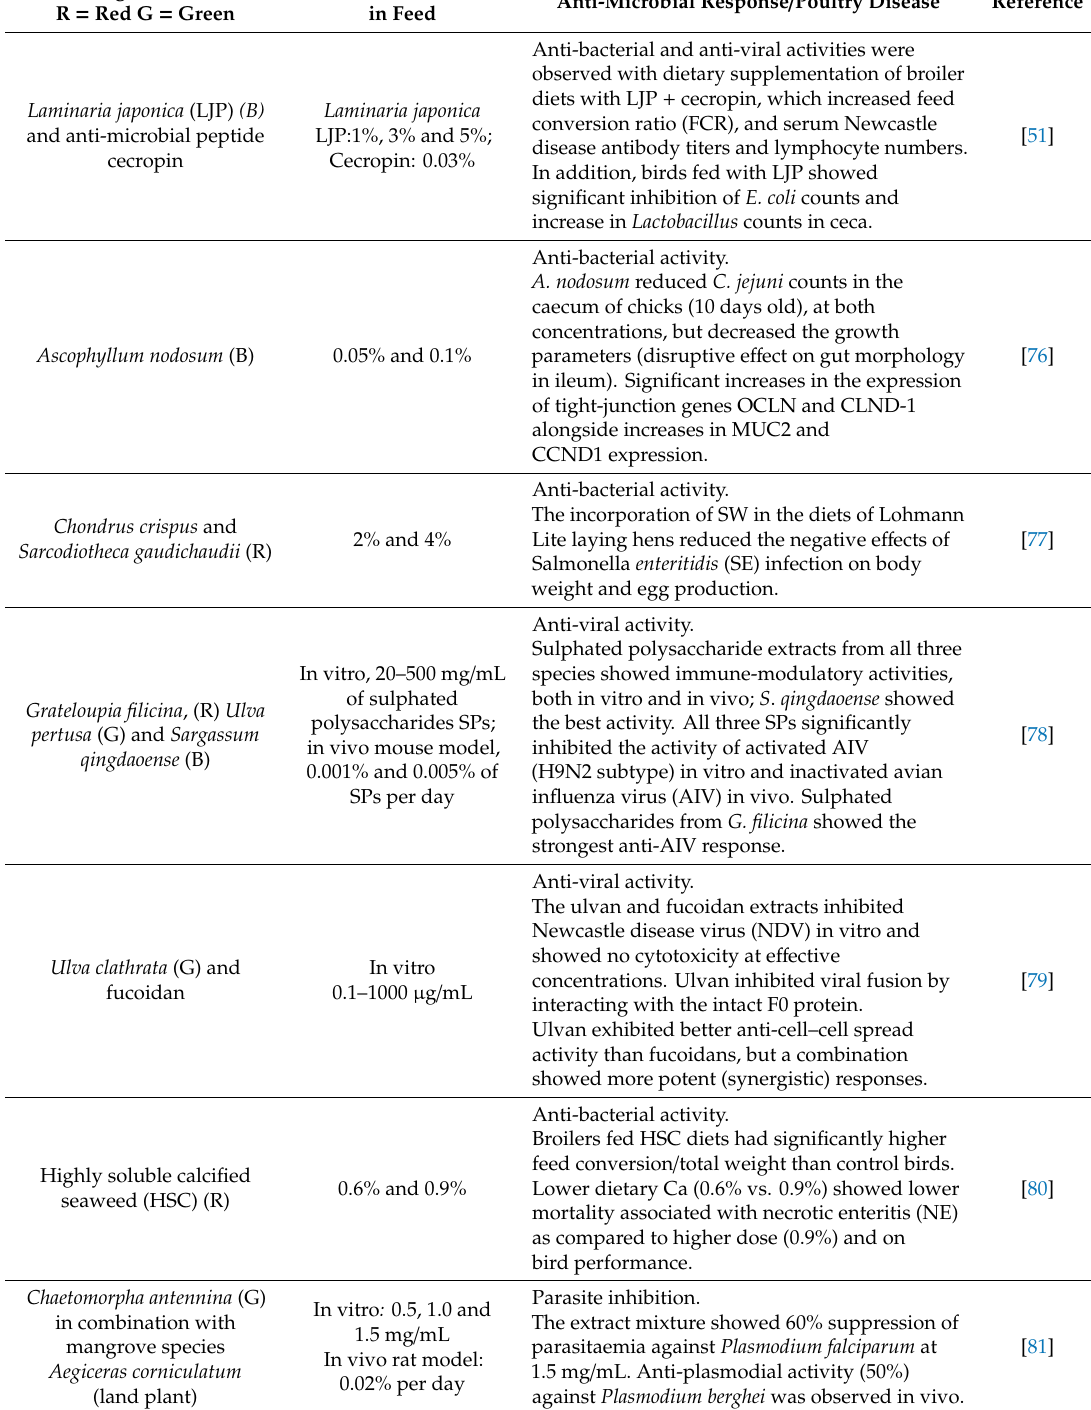
Table 1. Use of seaweeds (SW) as anti-microbials in poultry